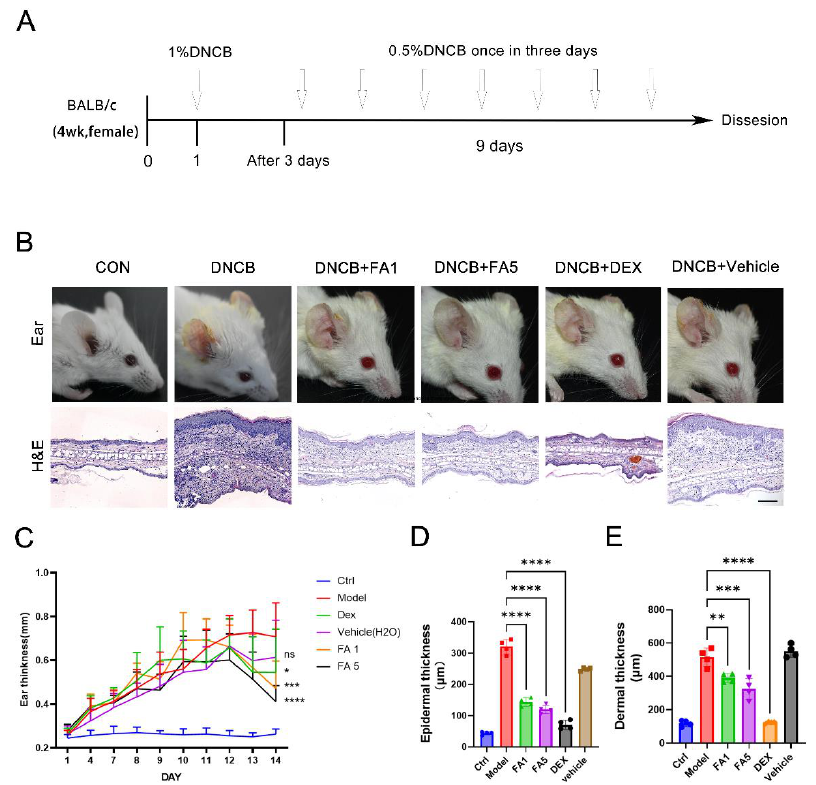
Figure 5. BALB/c mice induced with DNCB show decreased AD-like symptoms and histological changes following treatment with FA. ( A ) Diagram of AD induction. ( B ) Representative images of ear lesions and HE staining of mice on the last day. ( C ) The ear thickness changes in 14 days. ( D ) The changes in epidermis and dermal thickness induced by DNCB ( D , E ) ( n = 4). Scale bar = 100 μm. **** p < 0.0001, *** p < 0.001, ** p < 0.01, * p < 0.05, ns means not significant difference.